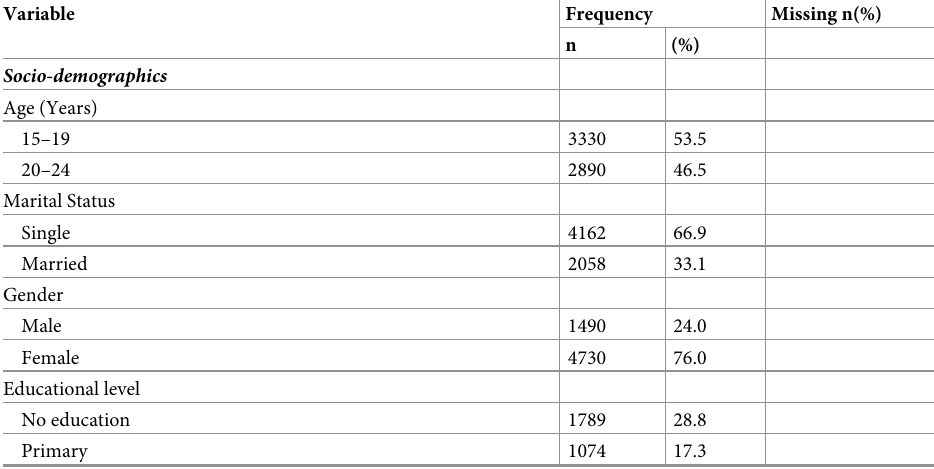
Table 1. Demographic characteristics, HIV knowledge, and behaviour (n =